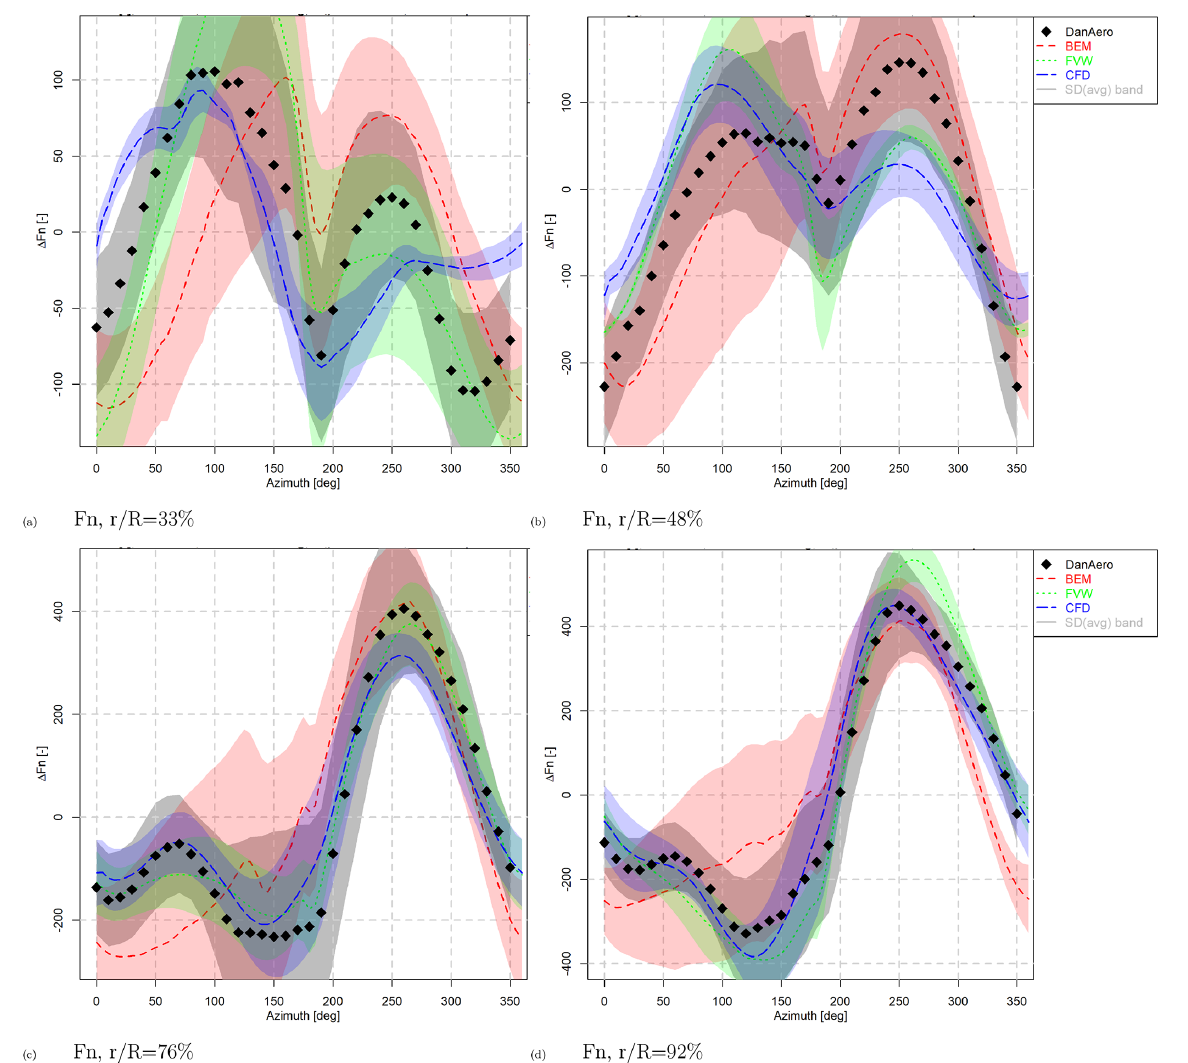
Figure 10. Normal force (Fn) variation by model types, Case